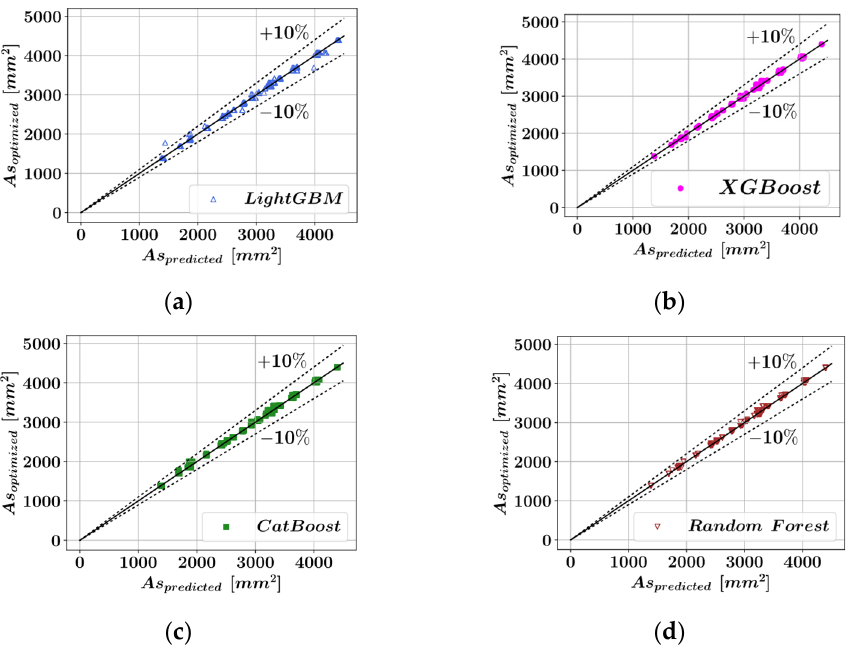
Figure 6. Comparison of the predicted and optimized dimensions. ( a ) LightGBM. ( b ) XGBoost. ( c ) CatBoost. ( d ) Random Forest. Table 2. Prediction accuracy of the machine learning models.